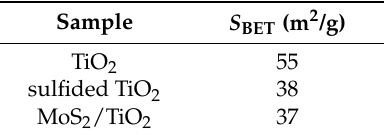
Figure 6. TPs identified during the degradation of CBZ. In black, TPs formed with all materials; in red, TPs characteristic of the TiO 2 P25 degradation pathway; in blue, detected only with MoS 2 /TiO 2 and/or sulfided TiO 2 samples. Table 2. Surface area